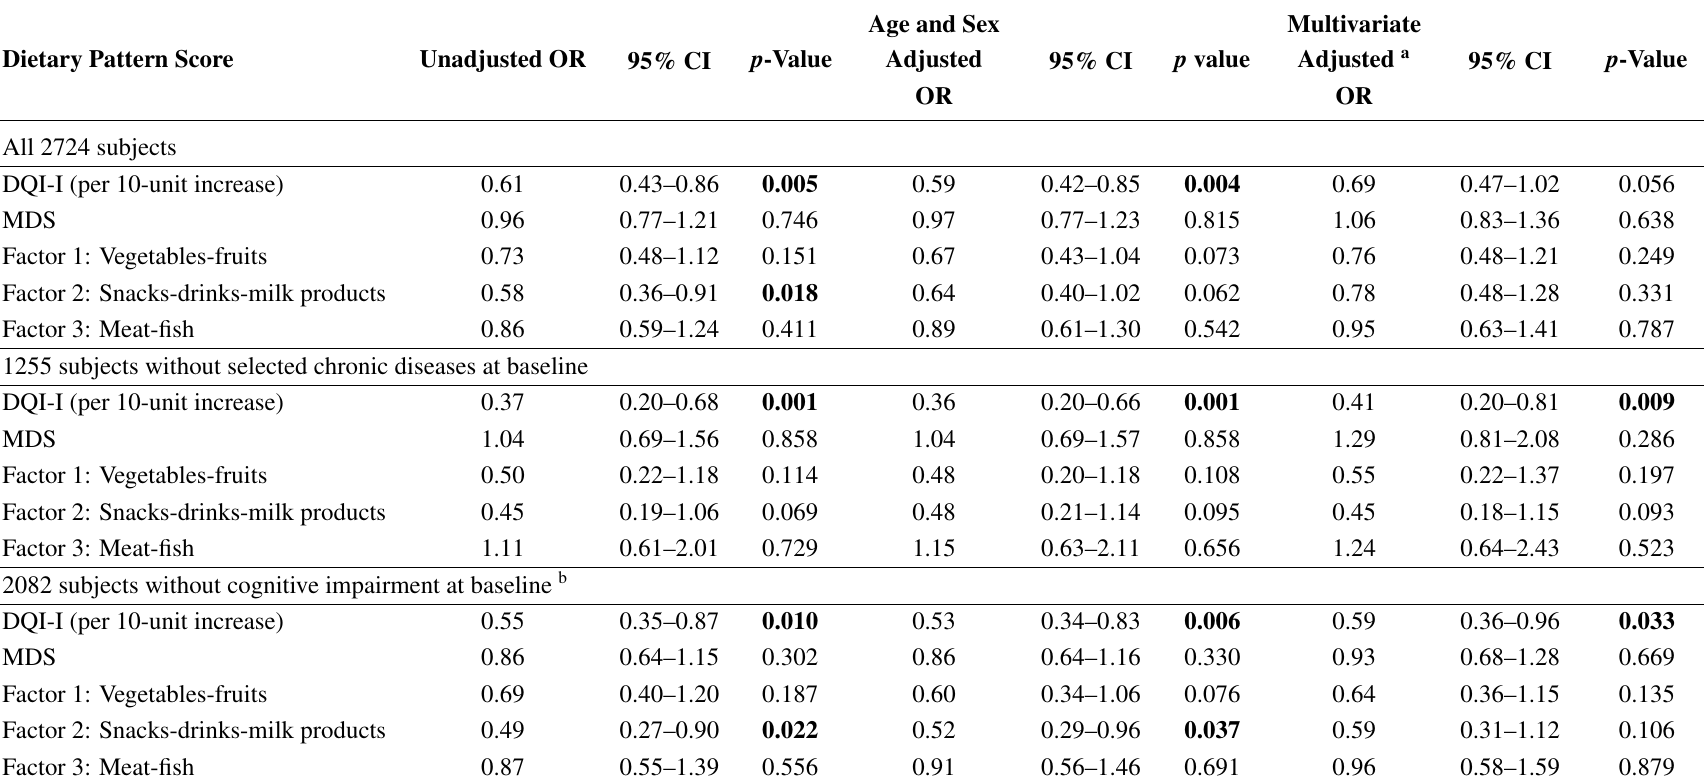
Table 4. Crude and adjusted associations between each dietary pattern score and incident frailty ( n = 2724). Dietary Pattern